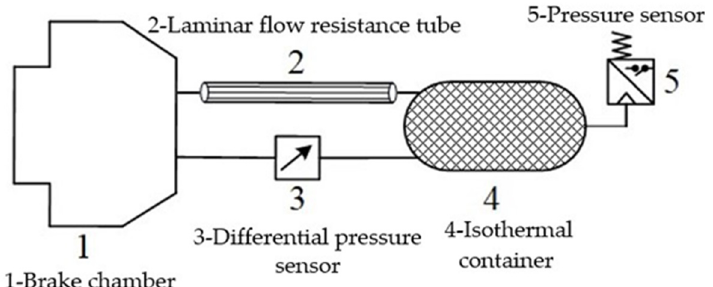
Figure 1. Schematic diagram of the measurement principle of pressure change rate for electronically controlled pneumatic brakes of a commercial vehicle.